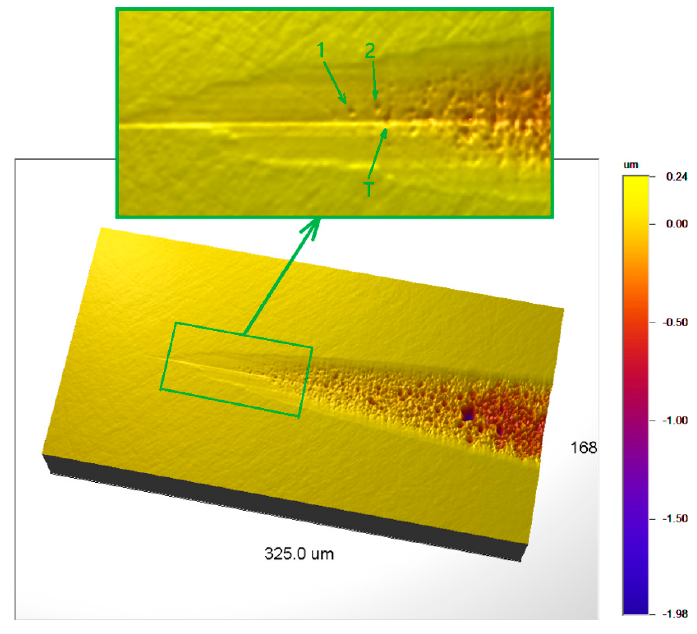
Figure 8. Groove morphology by plunge cutting.